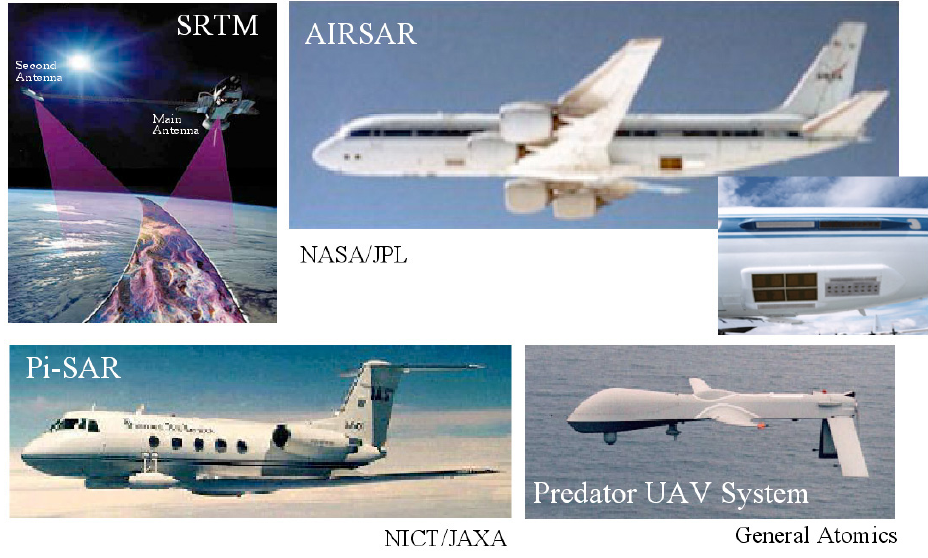
Figure 4. Illustration of SRTM, AIRSAR, MQ-1 Predator UAV carrying Lynx SAR, and Pi-SAR.